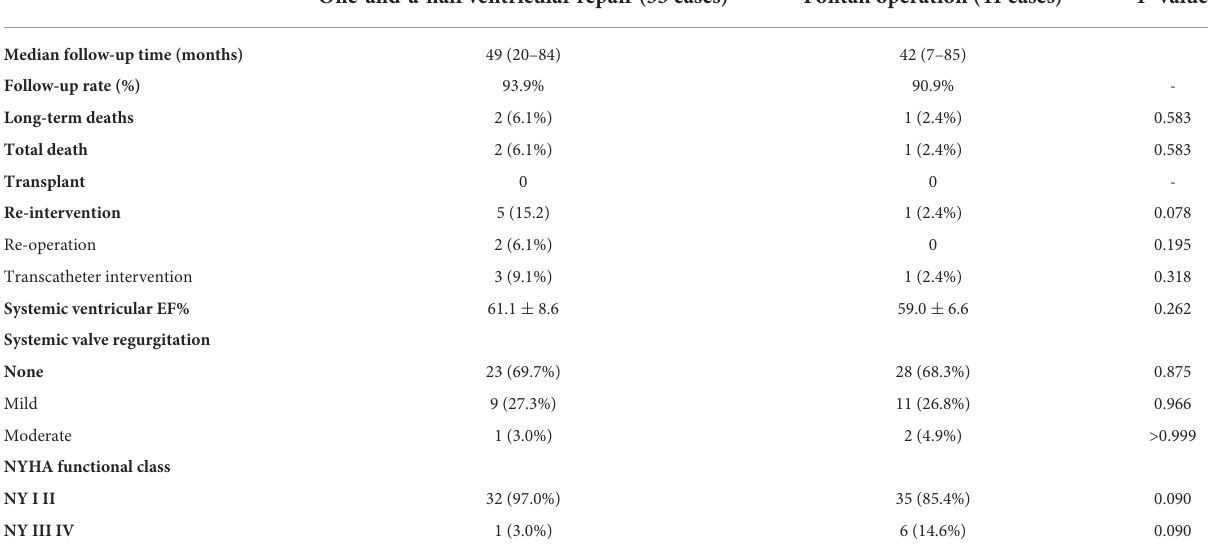
TABLE 3 Follow-up